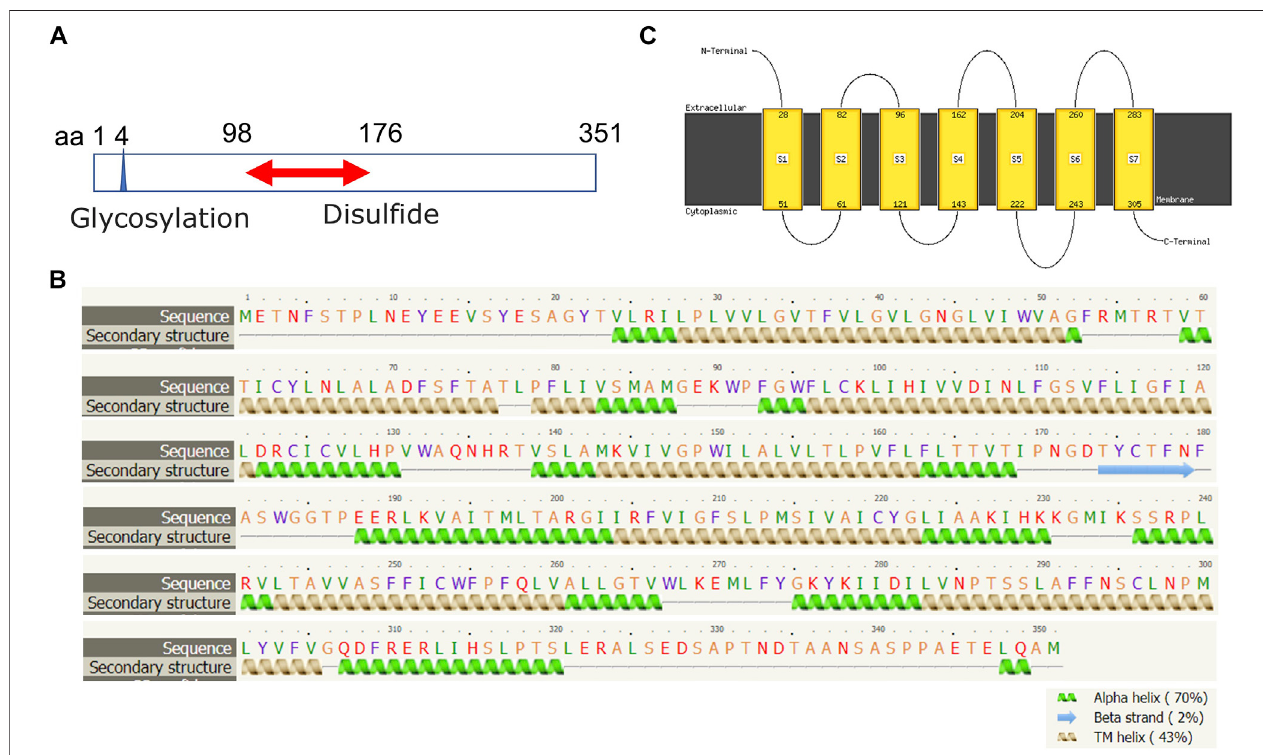
FIGURE8| MolecularstructuralanalysisofFPR2.MolecularstructureofFPR2,predictedbybioinformaticsinformationbasedon (A) Uniprot(https://www.uniprot. org/), (B,C) the Phyre2 web portal (http://www.sbg.bio.ic.ac.uk/phyre2/) all showing characteristics of G protein-coupled receptor.